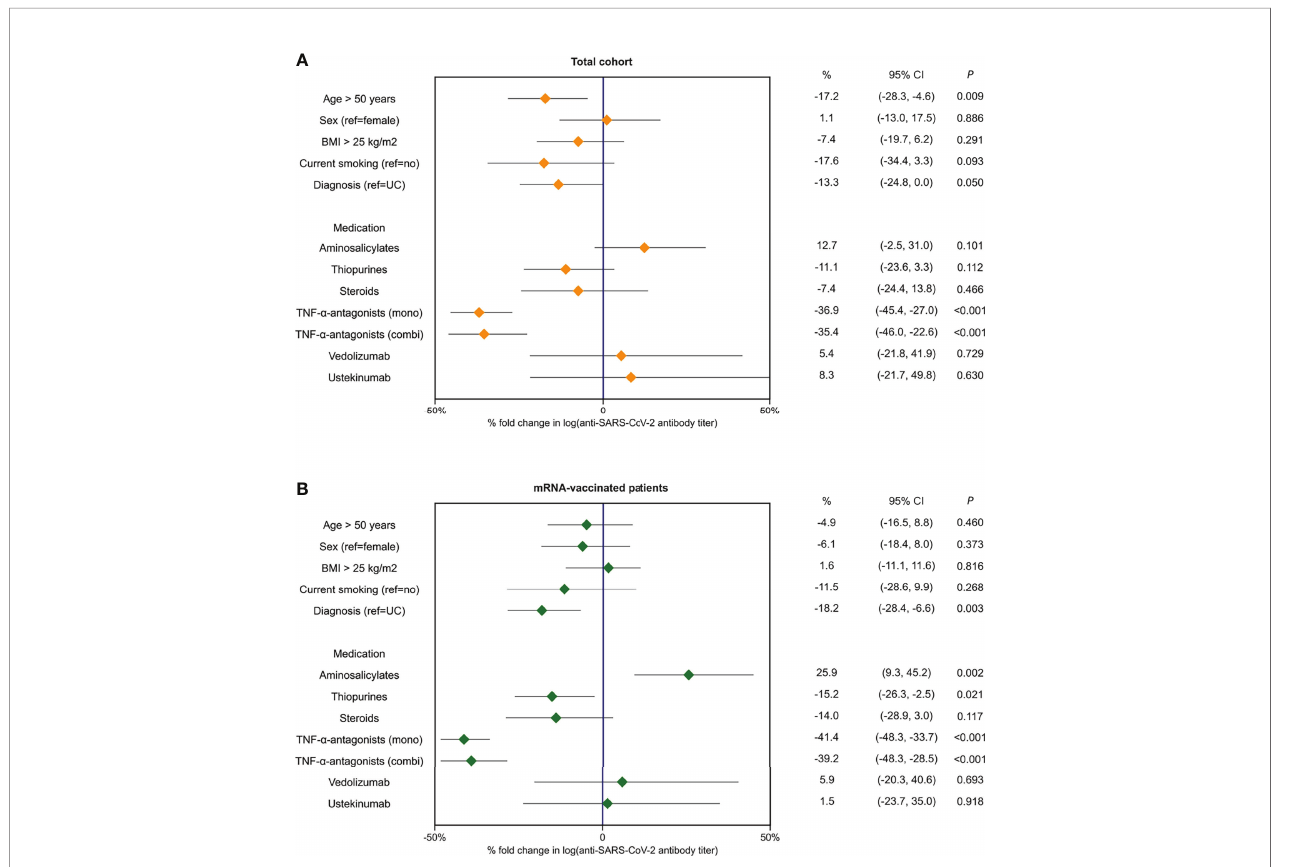
FIGURE 4 | Forest plots demonstrating percentages (%) of fold change in log-transformed antibody titers based on exponentiated coef fi cients derived from multivariable linear regression analyses in the full cohort of patients with IBD (A) and in patients who received mRNA-type vaccines ( B ).